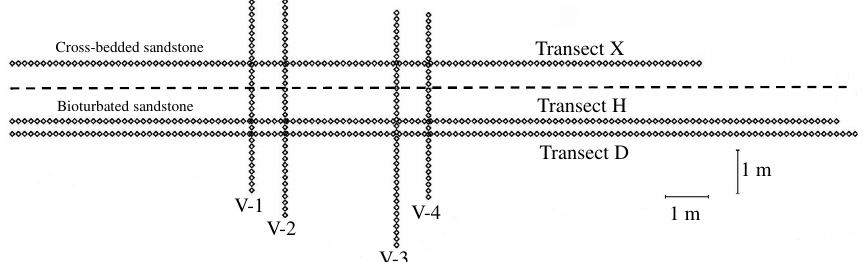
Fig. 8. Locations of nitrogen minipermeameter measurements along sandstone outcrop near Escalante, Utah. Modified after Castle et al. (2004).